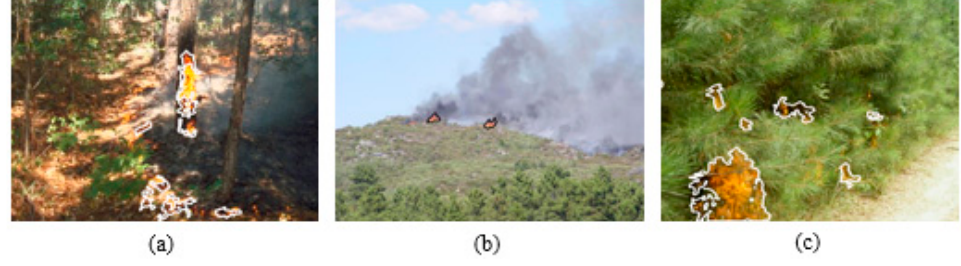
Figure 8. Detections of initial forest fires, realized with FFDI at short distances with; ( a ) ρ min = 0.2; ( b ) ρ min = 0.7; ( c ) ρ min = 1.